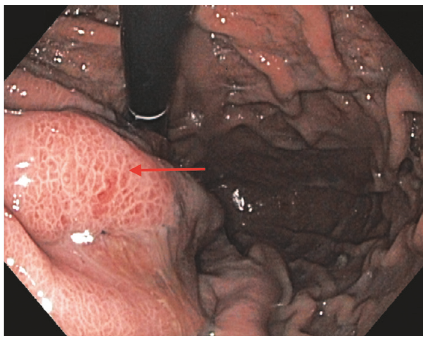
Figure 2: Endoscopy image; extrinsic bulge with erythematous mucosa.